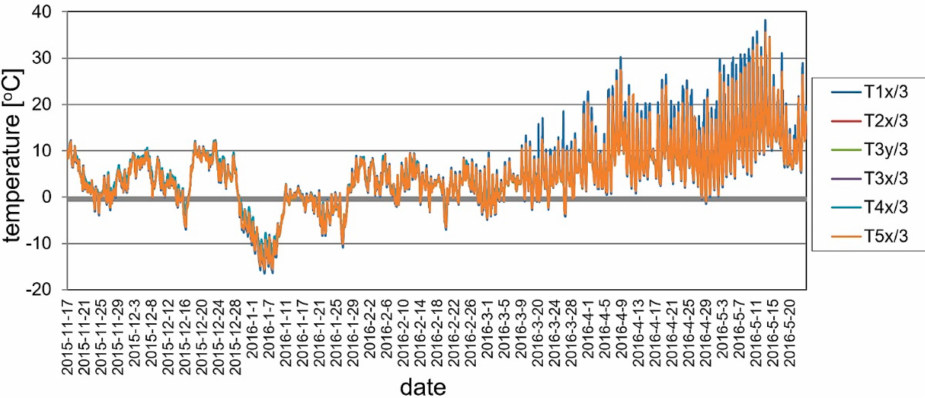
Figure 26. Temperature changes during a six month monitoring period.